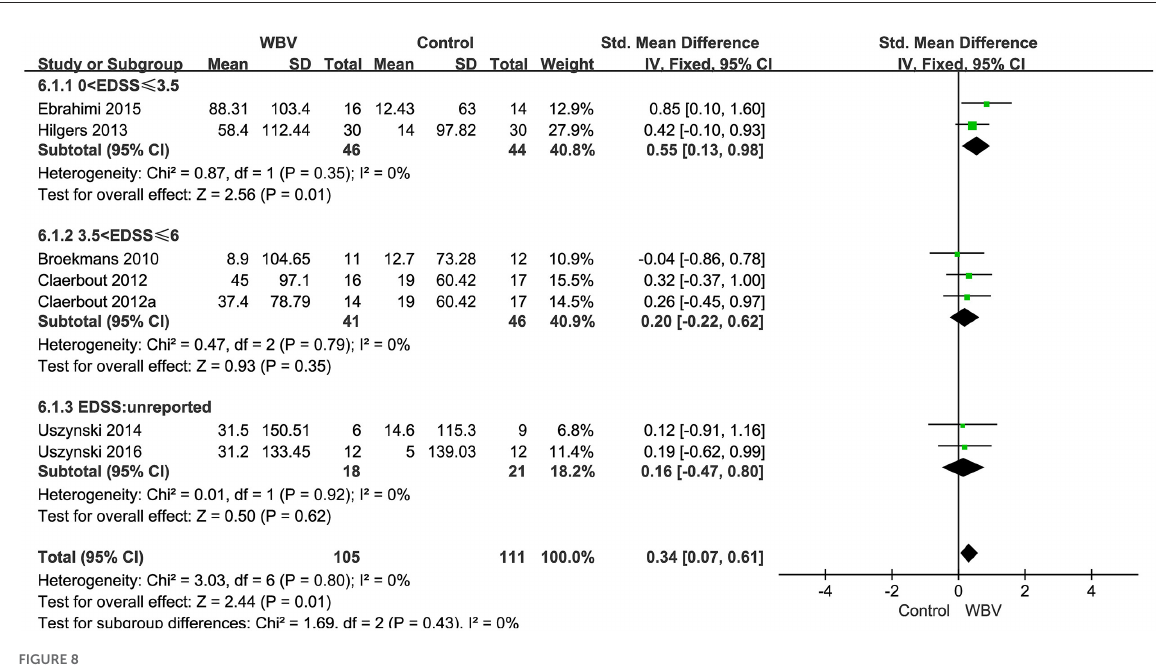
FIGURE8 Forest plot showing the effects of WBV on walking endurance in subgroups stratified according to the EDSS